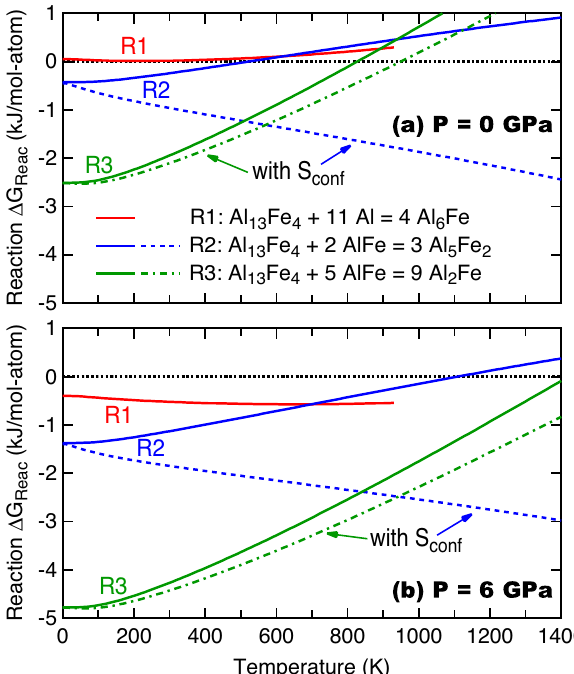
Figure 4. Reaction Gibbs energies (ΔG reac ’s) under external pressure P = 0 GPa ( a ) and 6 GPa ( b ) with and without considering the ideal configurational entropies (S conf ’s) of Al 5 Fe 2 and Al 2 Fe, respectively; see Eqs. (4) and (5). The ΔG reac curves for reaction R1 are plotted up to 930 K, which is slightly below the melting point of Al (933